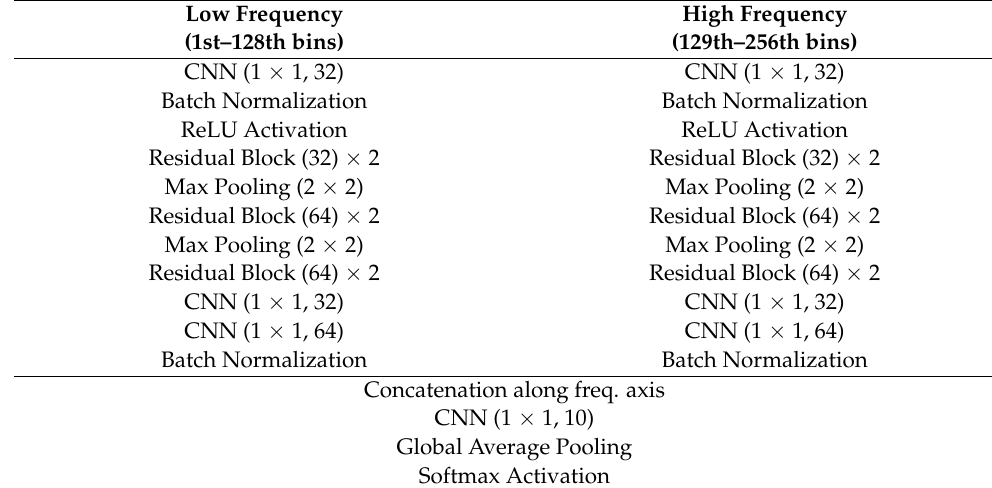
Table 1. Structure of the student model. CNN ( a × b , c ) means a convolutional layer with ( a × b ) -sized kernels and c output channels, and Residual Block ( a ) × b means a residual block with a output channels and b depthwise